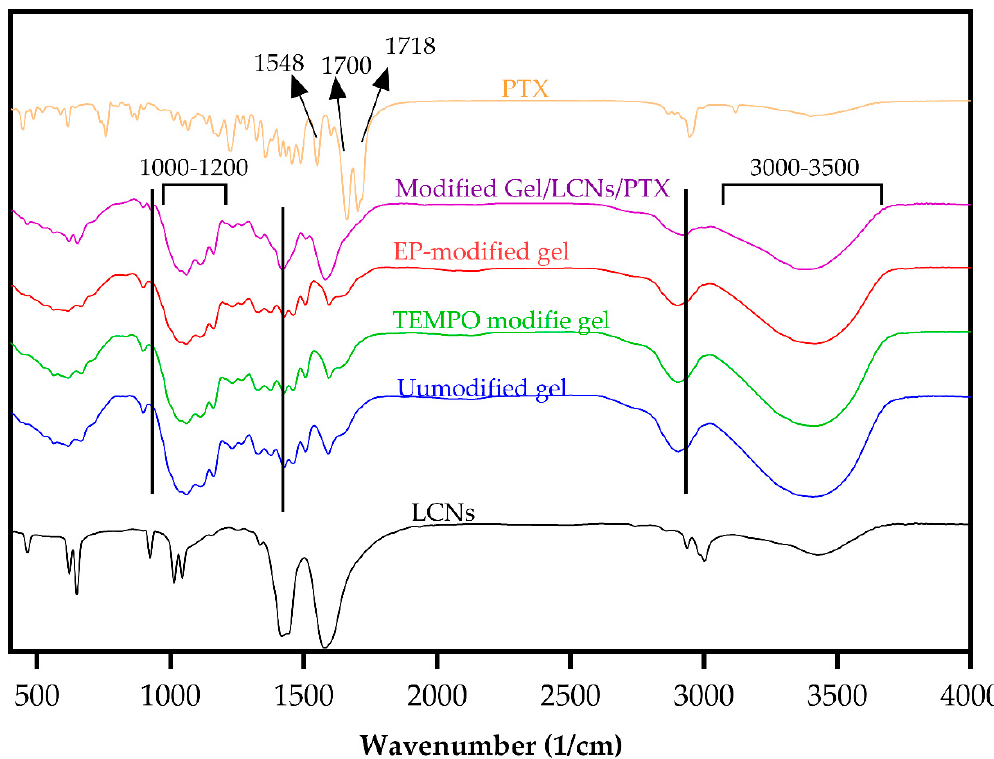
Figure 4. FTIR spectra of PTX, LCNs, unmodified hyhdrogels, TEMPO-modified hydrogels, EPI/TEMPO-modified hydrogels, and EPI/TEMPO-modified hydrogels containing LCNs/PTX.